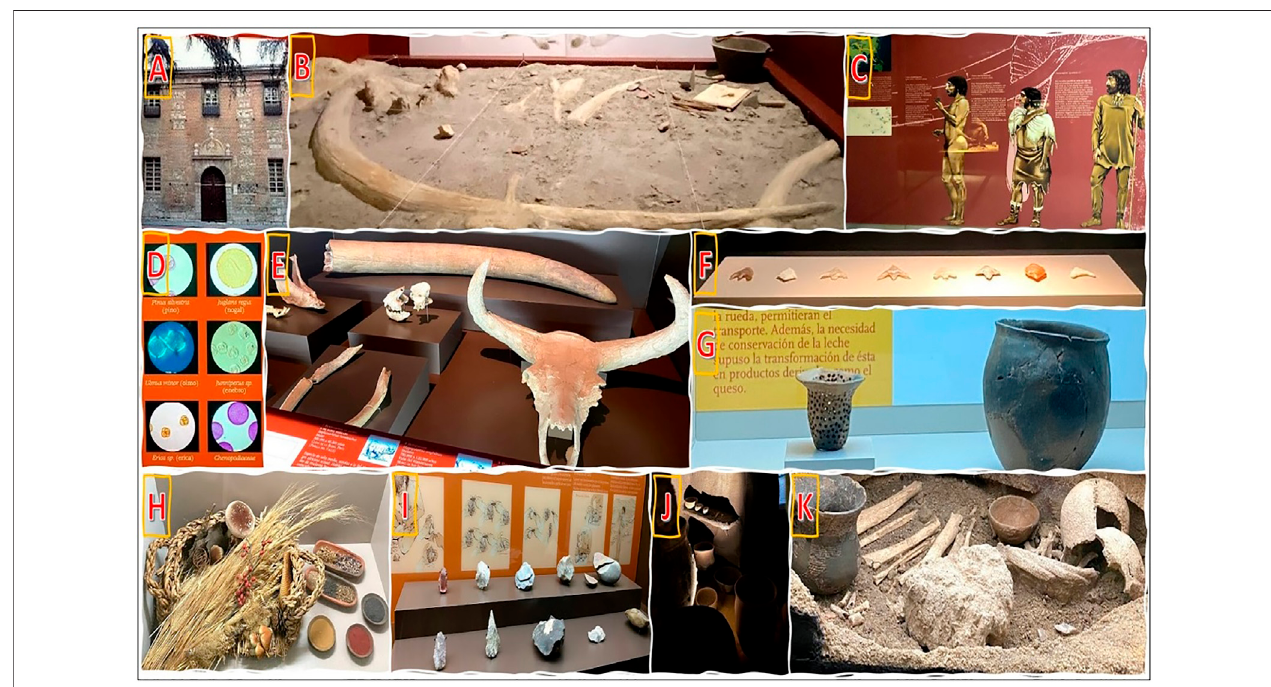
FIGURE 3 | Community of Madrid Regional Archaeological Museum. (A) Facade of the museum. (B) Archaeological/paleontological excavation. (C) Prehistory (room “ Before the time of Man ” ). (D) Paleoenvironment (palynology). (E) Paleoenvironment (fauna). (F) Hunting (arrowheads). (G) Domestication (cheese and container). (H) Harvesting and agriculture. (I) Lithic artifacts for everyday life. (J) Interior of a house. (K) Individual burial (social